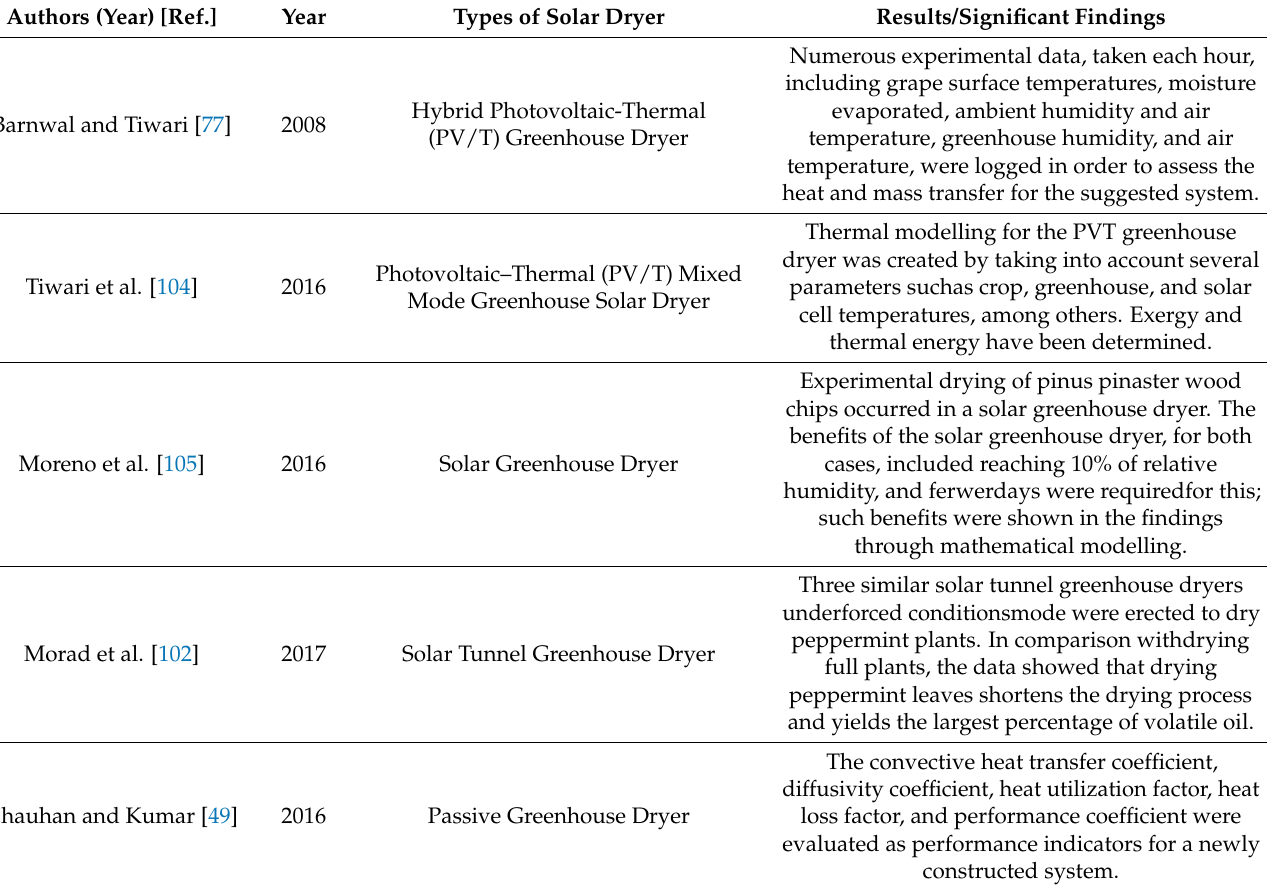
Table 2. Comparison of various types of greenhouse